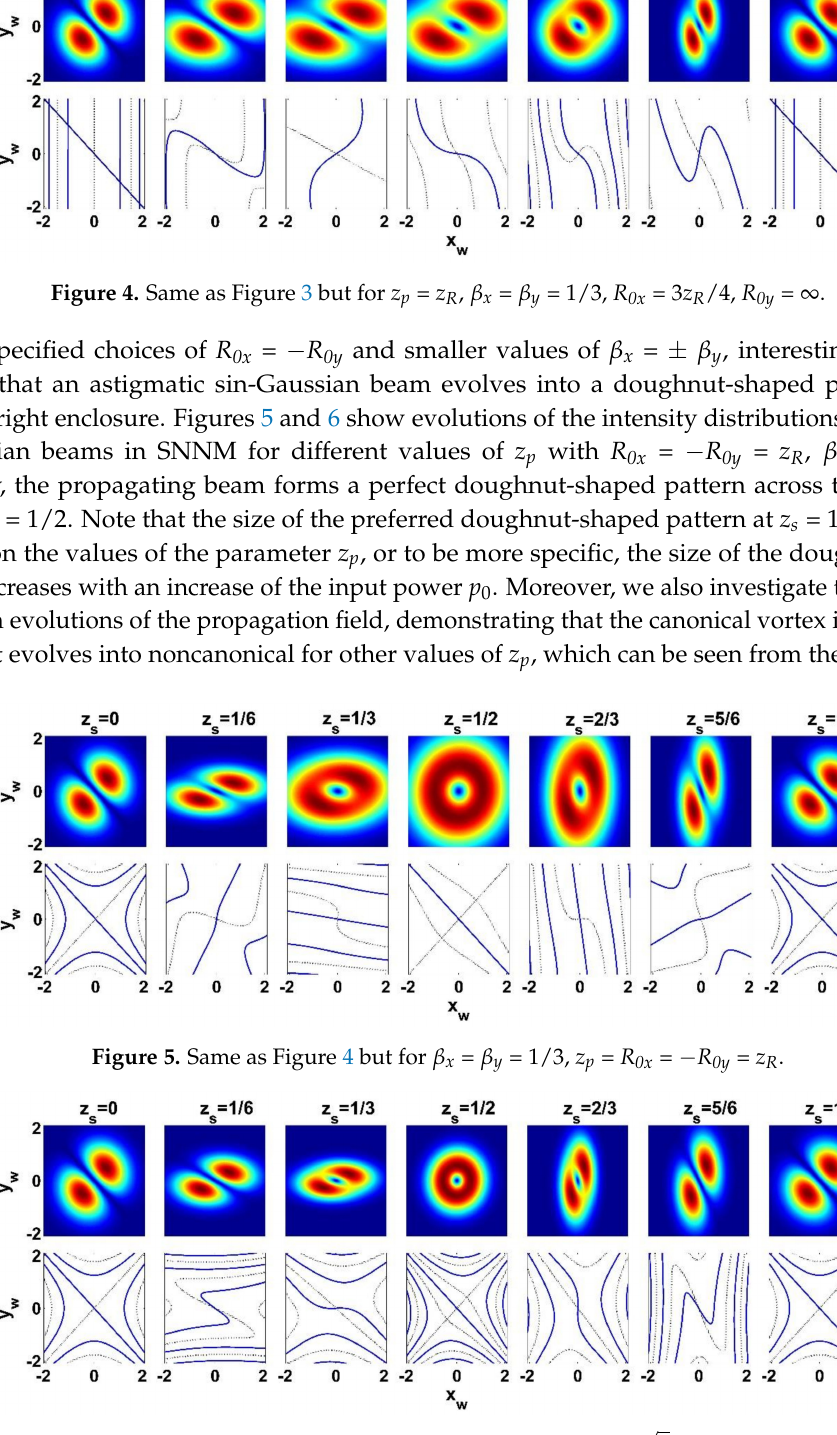
Figure 6. Same as Figure 5 but for z p = z R /